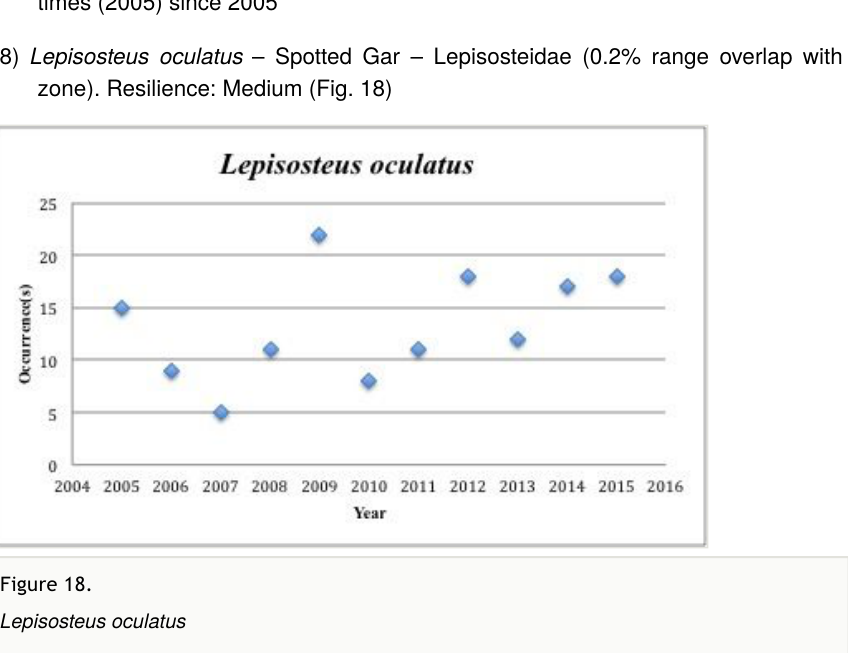
Figure 18. Lepisosteus